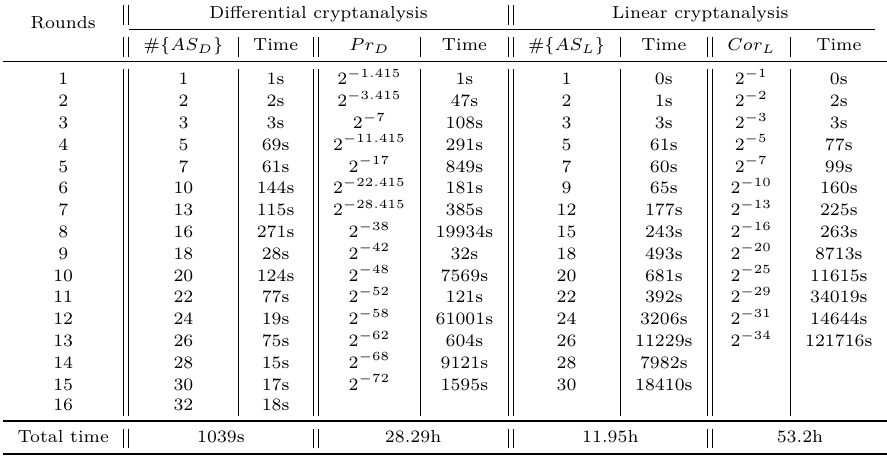
Table 3: Experimental results of